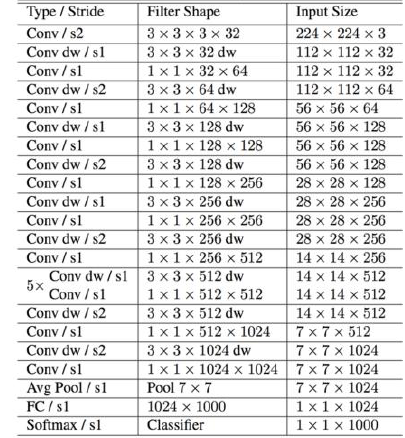
FIGURE II. MOBILENET